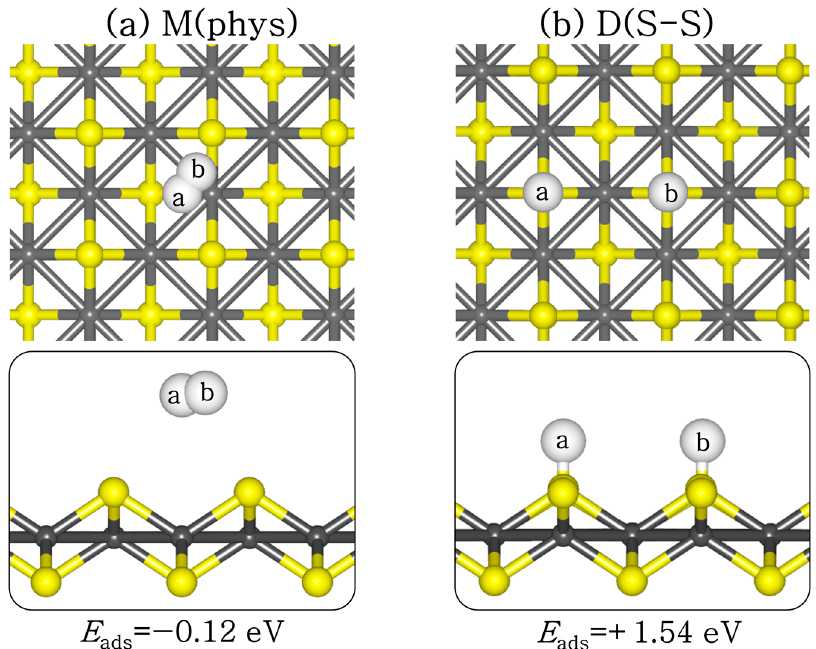
Figure 5. Lowest-energy adsorption structures of ( a ) molecular (M) and ( b ) dissociated (D) H 2 on perfect FeS (001) surface, in top ( top ) and side ( down ) views. (Atomic colour: Fe = grey, S = yellow, H = white.)